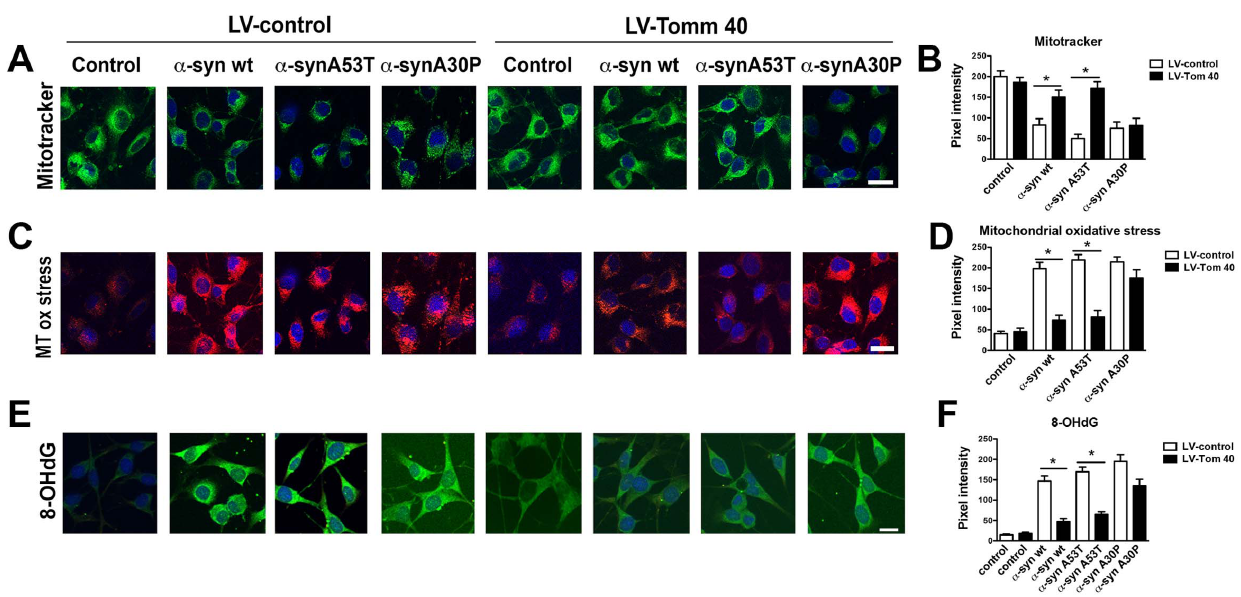
Figure 3. Mitochondrial impairment and oxidative stress induced by a -Syn-accumulation is reduced by overexpression of Tom40. B103 neuroblastoma rat cells were infected with lentivirus encoding human a -Syn wild type (LV- a -Syn) or its mutated isoforms A53T (LV- a -Syn-A53T) and A30P (LV- a -Syn-A30P); Tom40 (LV-Tom40) or a combination of these vectors. (A) Immunohistochemical detection of mitochondria by in vivo labeling with MitoTracker. (C) In vivo detection of mitochondria-derived reactive oxygen species (ROS) in cytoplasm by CellROX fluorogenic probes. (E) Fluorescent immunolabeling of oxidative DNA lesions (anti-8-OHdG). (B, D and F) Pixel intensity analysis of the corresponding immunosignals. Scale bar represents 10 m m. *p , 0.05 per Student’s t test.